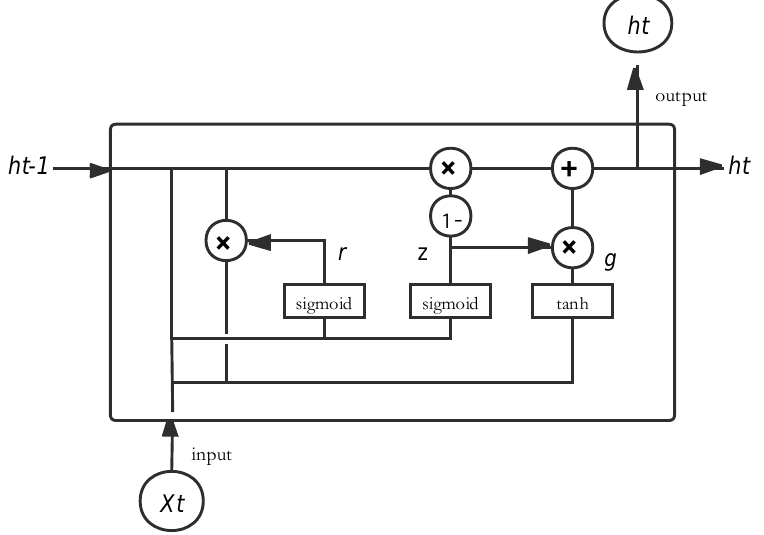
—Reset gate. It allows the cell to forget certain parts 𝑟𝑟 𝑡𝑡